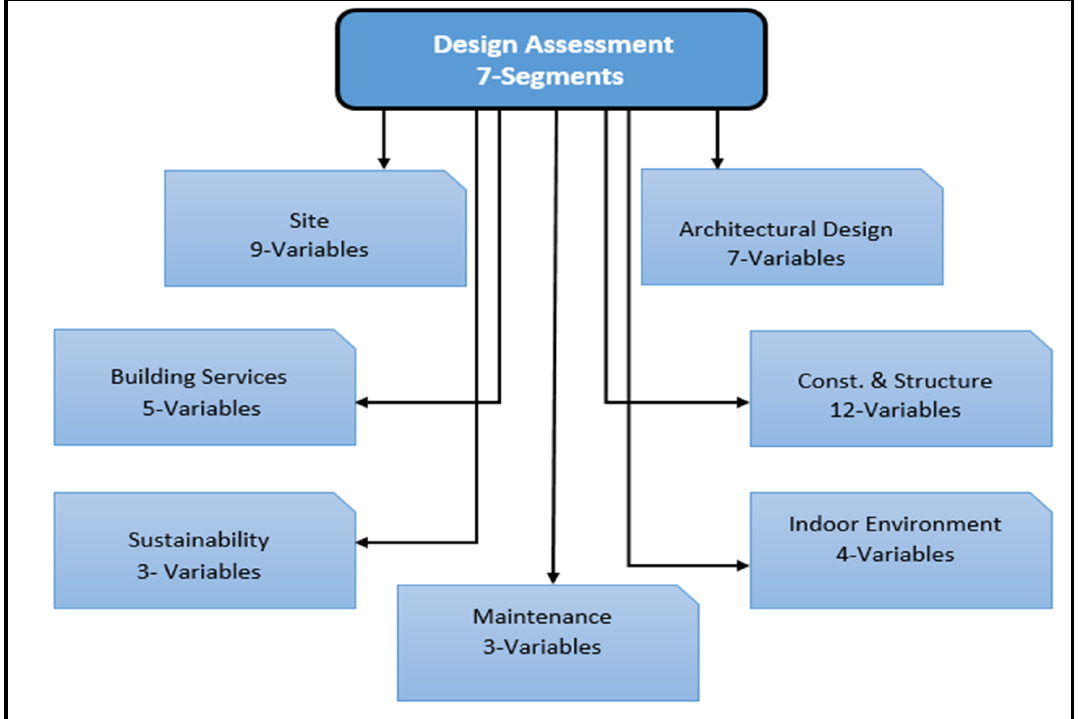
Figure 1. UAE residential building assessment model (RBAM).